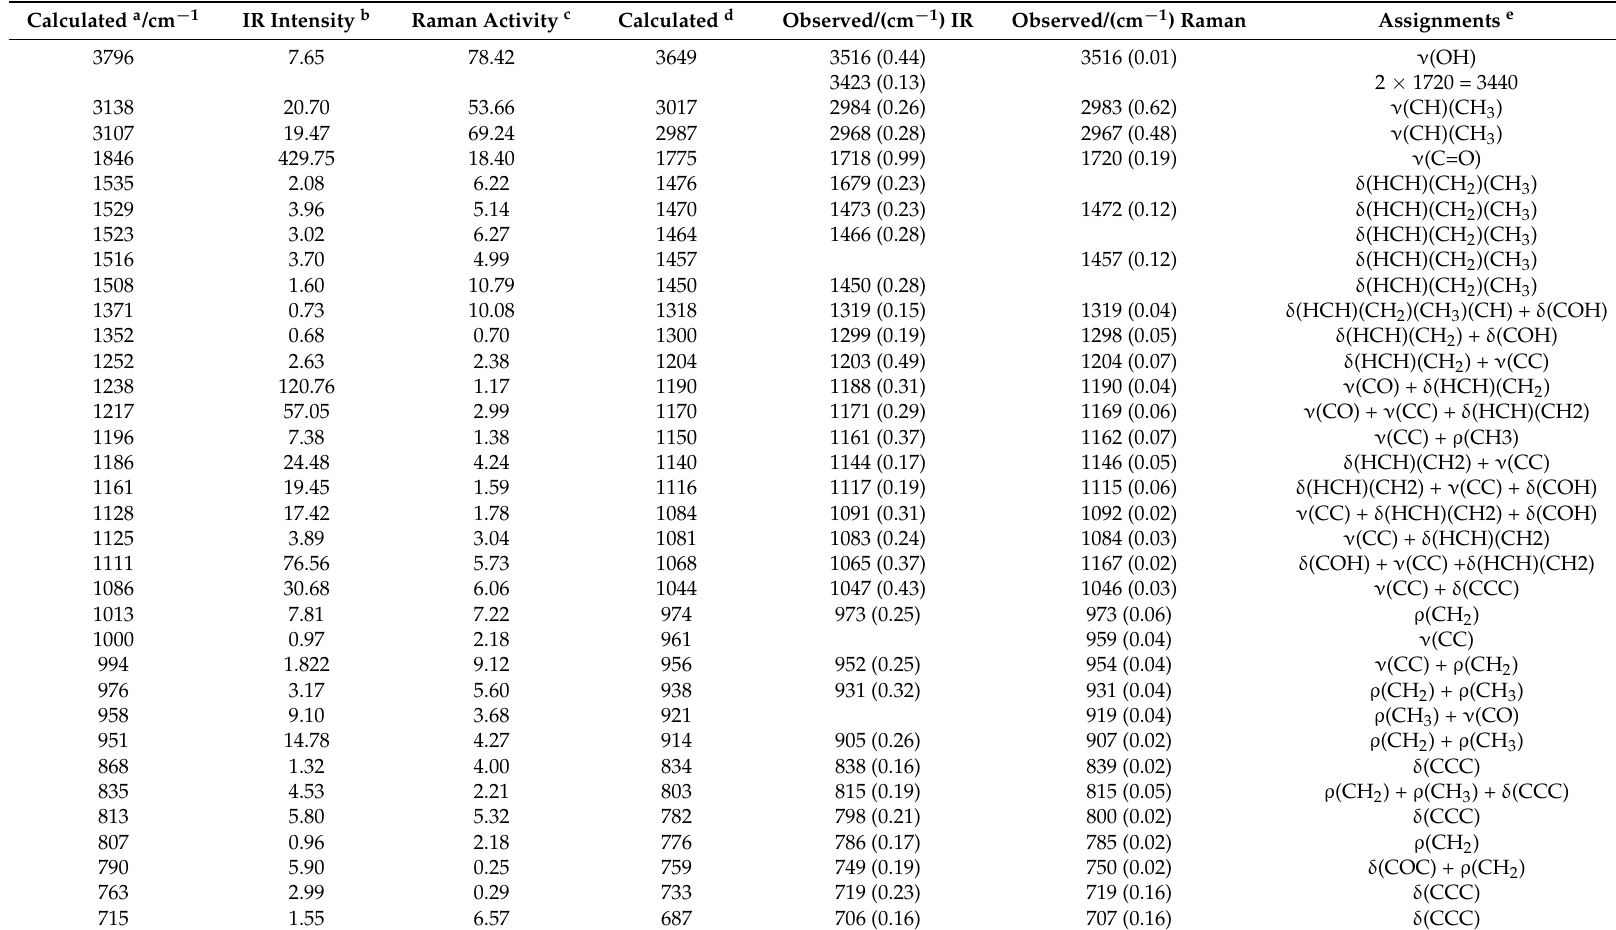
Table 1. Theoretical calculation (in cm − 1 ) of oxandrolone calculated by DFT (B3LYP/6-311G (d, p)) and its comparison with the experimental